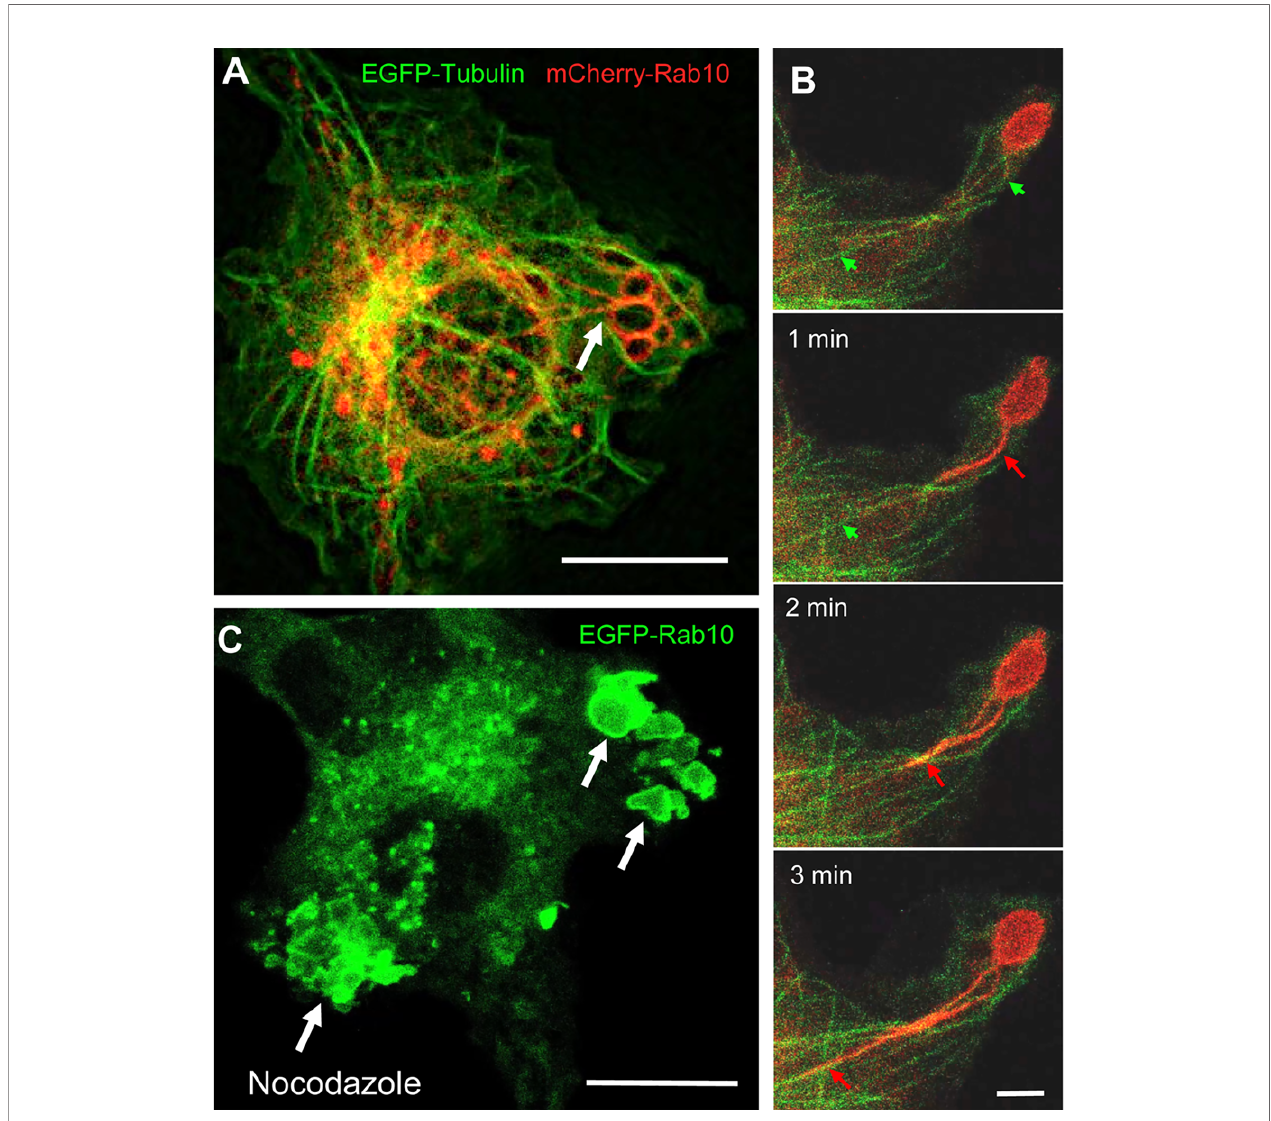
FIGURE 4 | The retrograde movement of Rab10-positive tubules is dependent on microtubules. (A) Epi fl uorescence microscopy of mCherry-Rab10 and EGFP- tubulin in live RAW 264 cells during PA-Rac1 ON-OFF cycling. Arrow indicates a Rab10-positive tubule extended from a peripheral premacropinosome. Scale bar=10 m m. (B) Higher-magni fi cation view of extending Rab10-positive tubules (red arrows) along microtubules (green arrows). Scale bar = 2 m m. (C) The extension of EGFP-Rab10 tubules was inhibited in nocodazole-treated RAW264 cells, while many Rab10-positive premacropinosomes (arrows) were formed. Scale bar = 10 m m. The corresponding movies are available in the ( Supplementary Material Movies 4 – 6